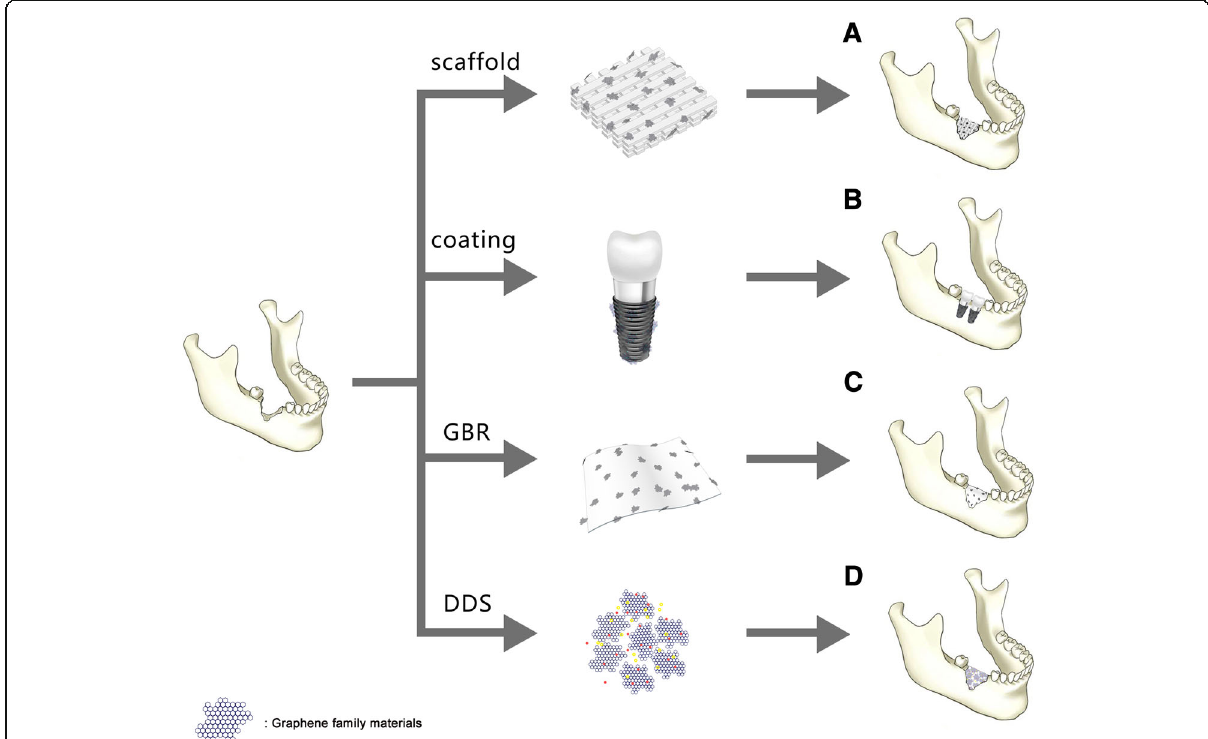
Fig. 2 A. Graphene family materials as scaffold or a reinforcement material in scaffold for bone regeneration. B. Graphene family materials as coating transferred onto the substrate for bone regeneration. C. Graphene family as an additive in guided bone membrane. D. Graphene family materials as drug delivery system facilitates bone